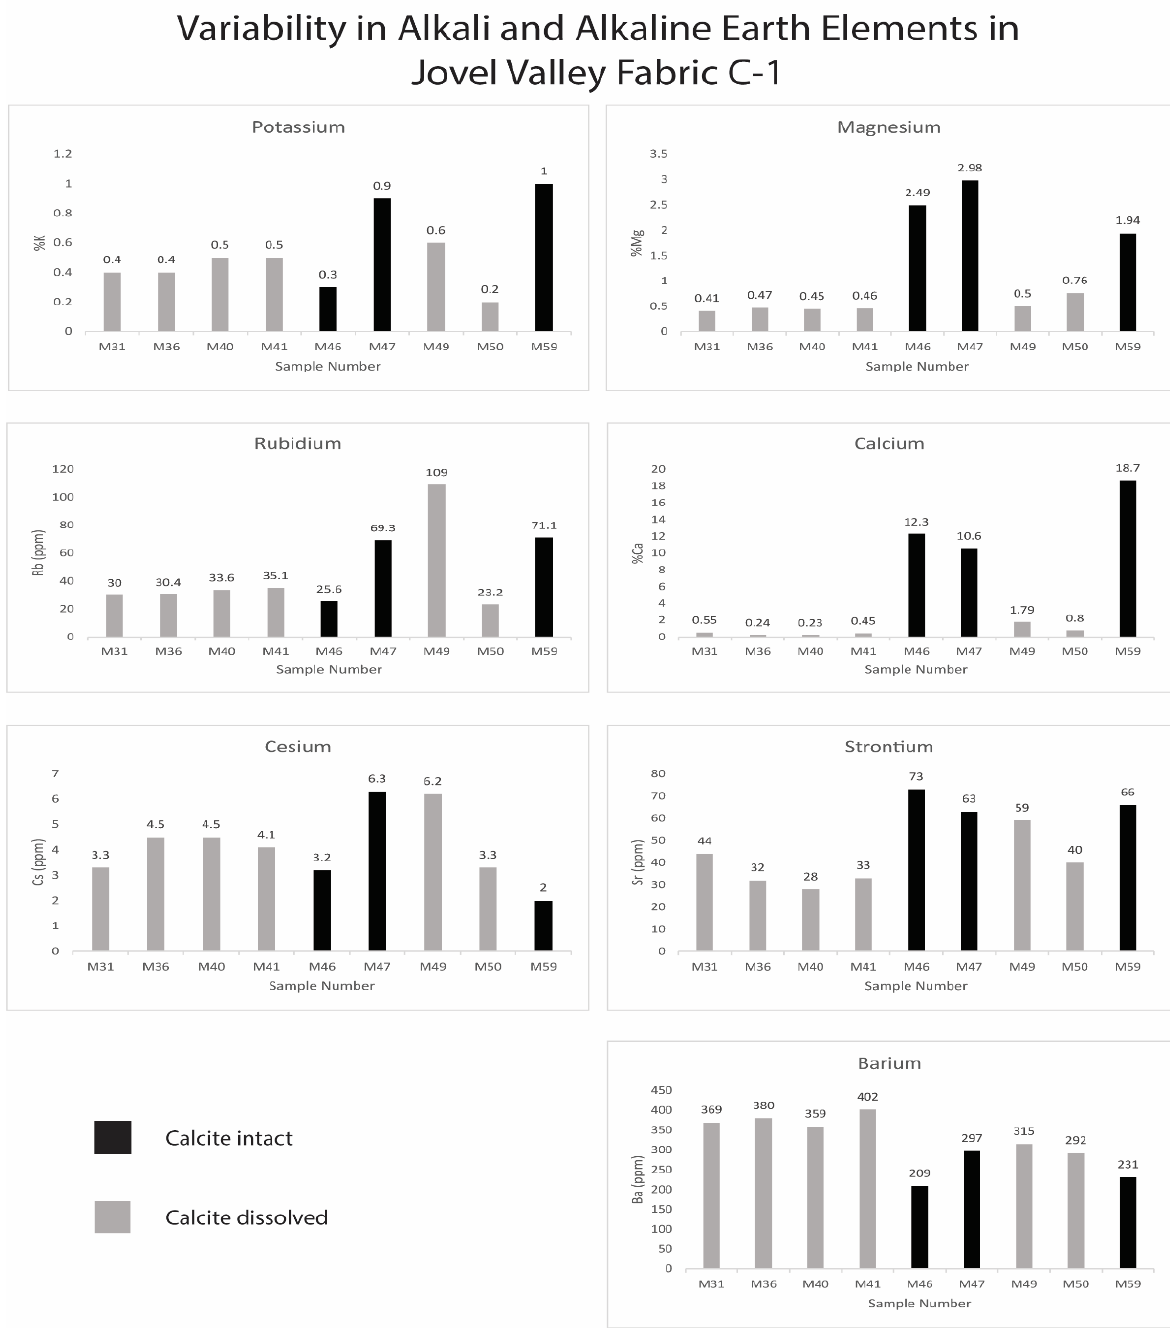
Figure 11. Graphs showing the concentration of various elements for C-1 samples both with and without intact calcite, at Moxviquil and CV-38. The stark contrast between the two groups is noticeable for multiple alkali and alkaline earth ele- ments.